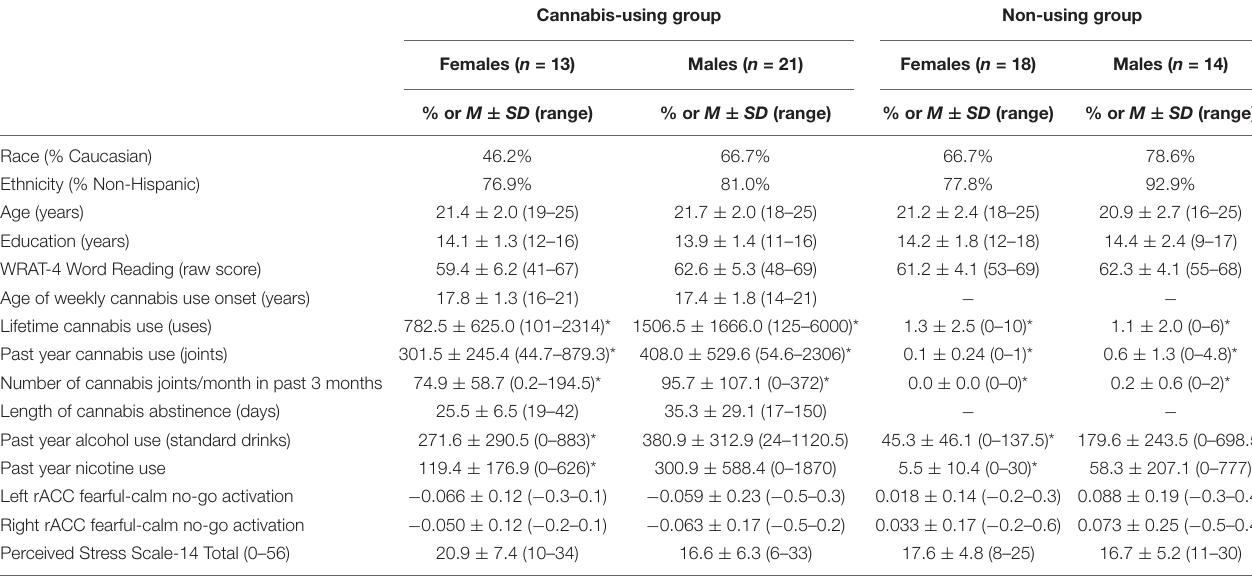
TABLE 1 | Participant demographics, substance use variables, BOLD activation in rACC, and PSS-14 scores.